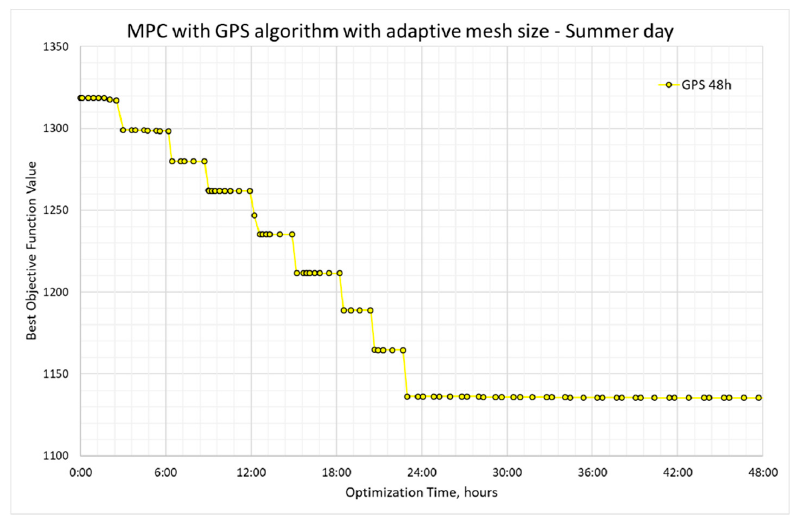
Figure 13. GPS optimization results on the summer day with its adaptive mesh size.